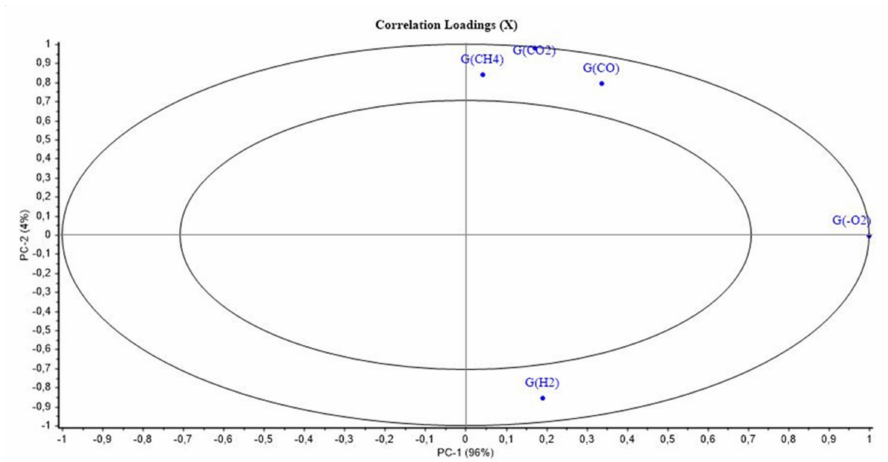
Figure 6. PCA loadings for PC1 and PC2 (Mod3).